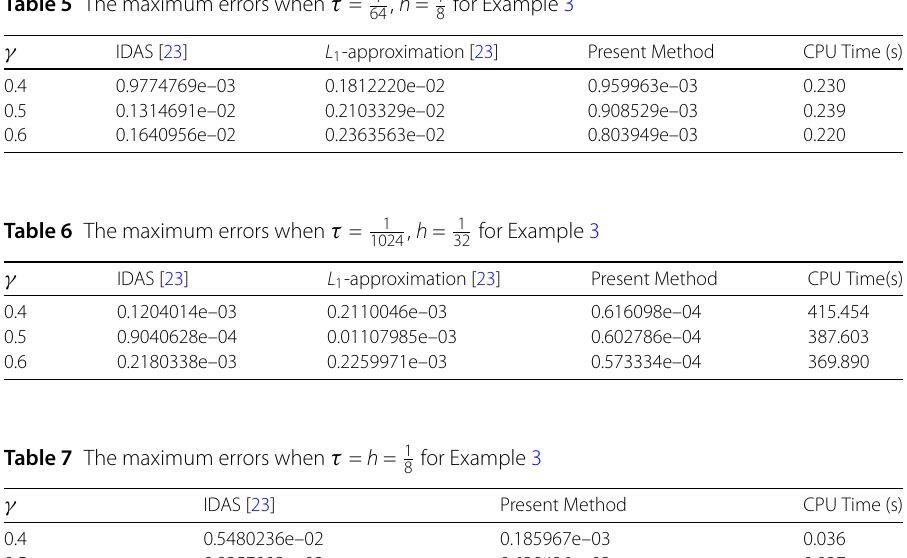
Table 7 The maximum errors when τ = h = 1